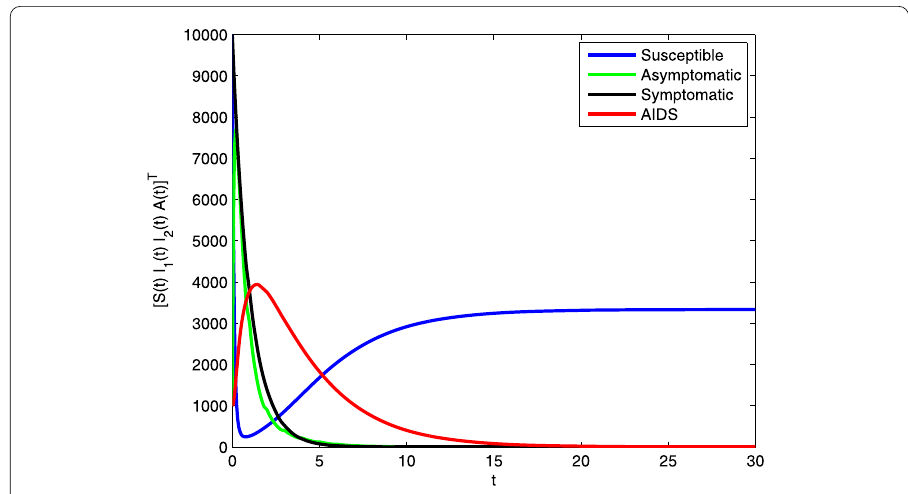
Figure 2 Simulations of system (1) with τ = 0.01, (cid:7) = 0, and ϕ = ϕ 1 = ϕ 2 = ϕ 3 = 0